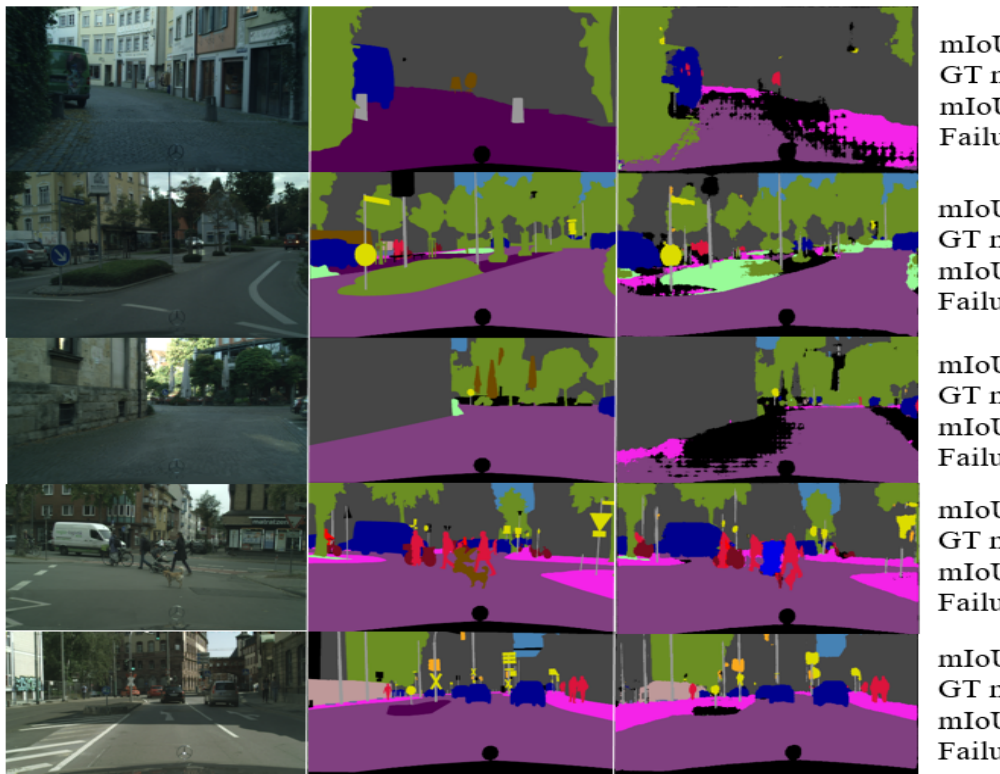
Figure 12. Examples of failure-case images in the Cityscapes